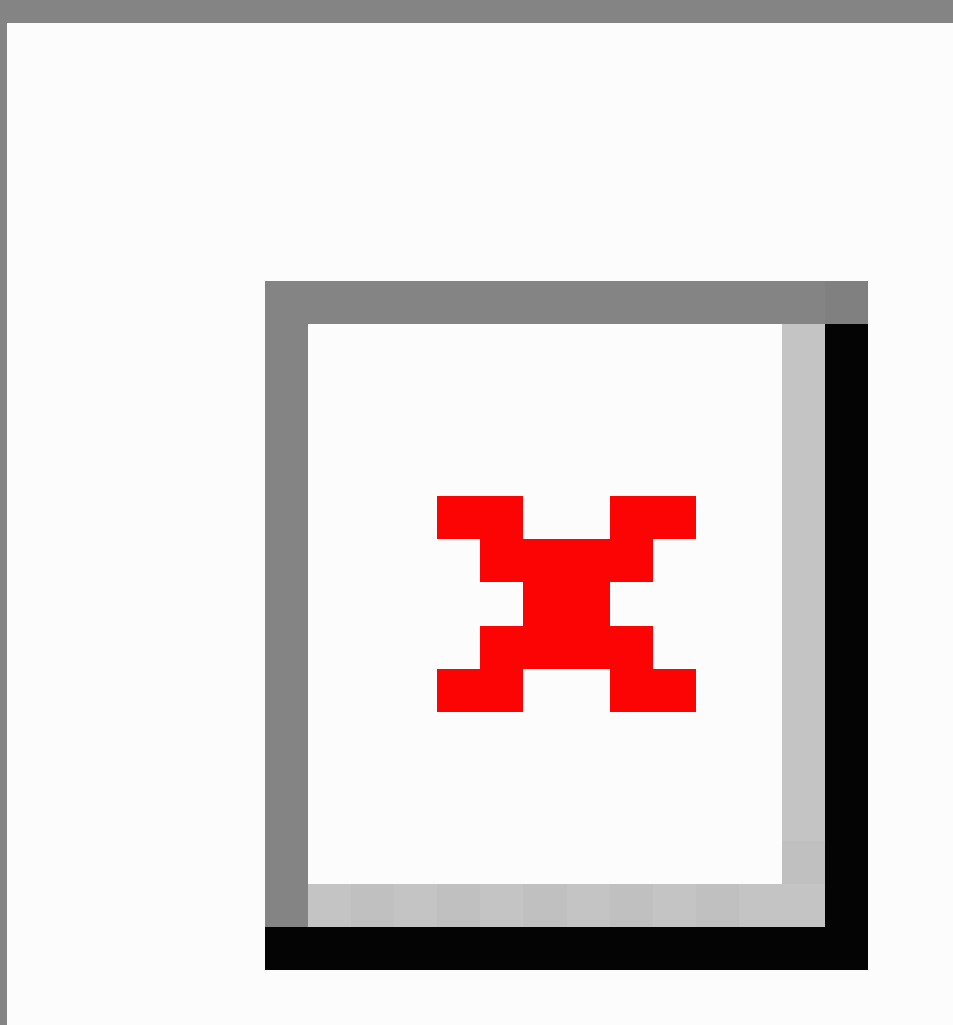
Figure 2. Map of hotspot locations with points on map represented by pie charts indicating the relative contributions of each community to the total visits recorded at that hotspot. Community III was primarily concentrated in the Gay Village neighborhood of the Ville-Marie borough of Montreal, whereas communities I and II primarily occupied the high-traffic commercial areas on either side of the Plateau-Mont-Royal neighborhood; all 3 communities coincided downtown. Each grid square is colored to represent the locally dominant community. Squares with no hotspots are colored to represent the dominant community at the nearest